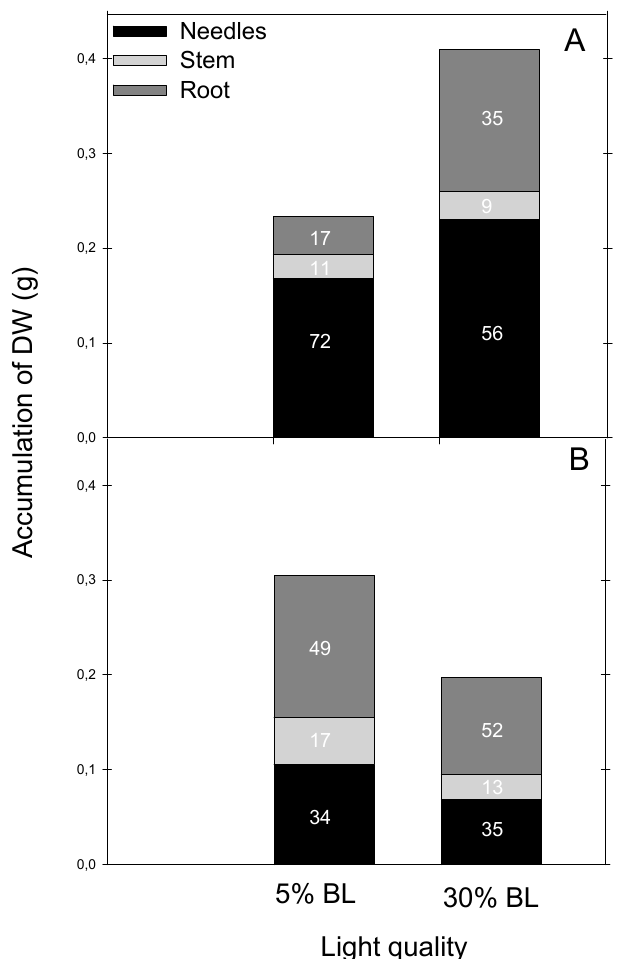
Figure 3. E ff ect of the blue light (BL) proportion on the accumulation of the dry weight (DW) (g) and distribution (%, numbers in the bars) between the needles, stem, and root of the Norway spruce ( A ) and subalpine fir ( B ) seedlings after 9 weeks of growth under a continuous lighting of 300 µ mol m − 2 s − 1 using HPS lamps (5% BL) or HPS + blue LED (30% BL) resulting in a similar R / FR ratio and phytochrome photostationary state (PPS), n = 10.